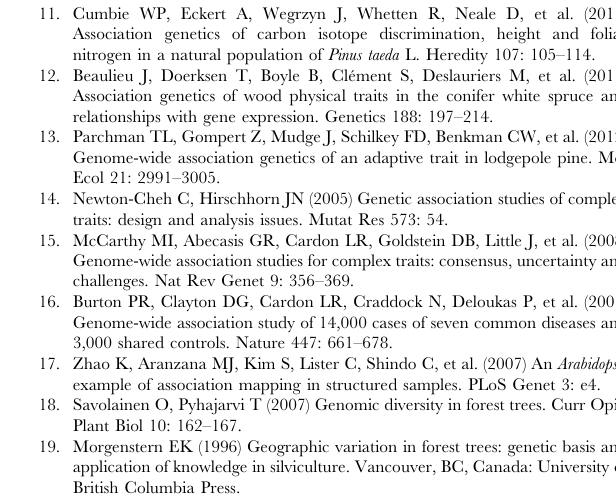
Figure S1 Plot of mean posterior probability (LnP(D)) values (open circles) per clusters (K), based on 10 replicates per K, generated by the STRUCTURE pro- gram (Pritchard et al., 2000), and delta-K analysis (filled squares) of LnP(D), according to Evanno et al., (2005). (a) plus trees in Kanto Breeding Region (b) natural population (c) core collection. (TIF) Figure S2 Relationship between phenotypic distance and marker distance. a) wood property, b) quantity of male strobili (TIF) Table S1 Genetic diversity statistics for plus trees and natural population in C. japonica.